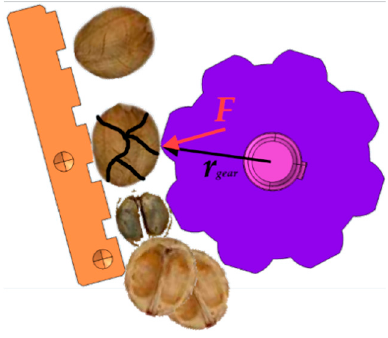
Figure 10. Fracture mechanism proposed.